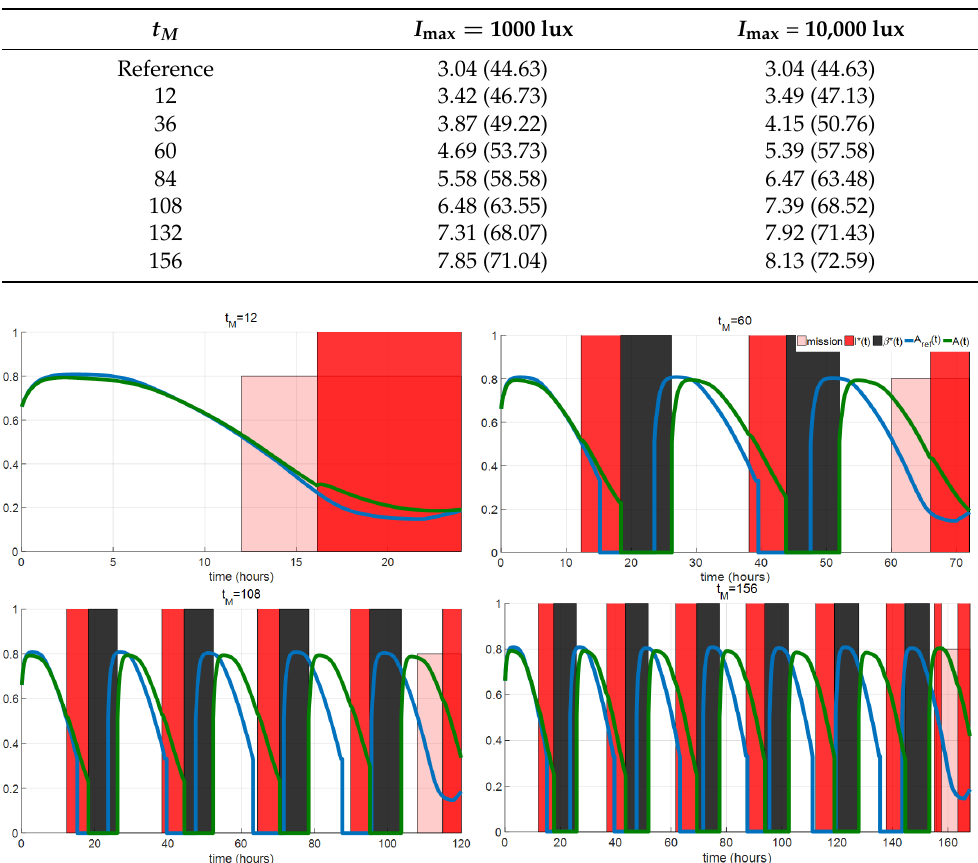
Table 2. The optimal cumulative alertness during the mission with different t M . The row ’Reference’ means only reference light in Equation (11) and spontaneous sleep schedule are used before mission without light and sleep optimization. The values in bracket give average subjective alertness in VAS with a unit of mm.